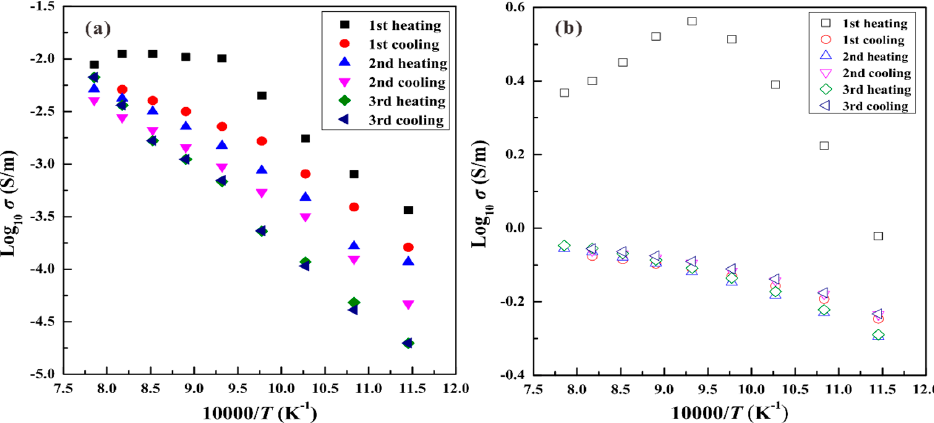
Figure 5. Electrical conductivities of the magnetite-free and 5 vol. % magnetite-bearing olivine aggregates as a function of the reciprocal temperatures during three heating–cooling cycles at 2.0 GPa. At 1273 K, each conductivity experiment was performed for at least 6–12 h in order to avoid the effects of disequilibrium of the thermal transfer, disequilibrium of texture and moisture of the sample. Three heating–cooling cycles over the temperature range of 673–1273 K were continuously measured for magnetite-free ( a ) and magnetite-bearing ( b ) samples, and electrical conductivities of samples in the third cycles were reproducible.